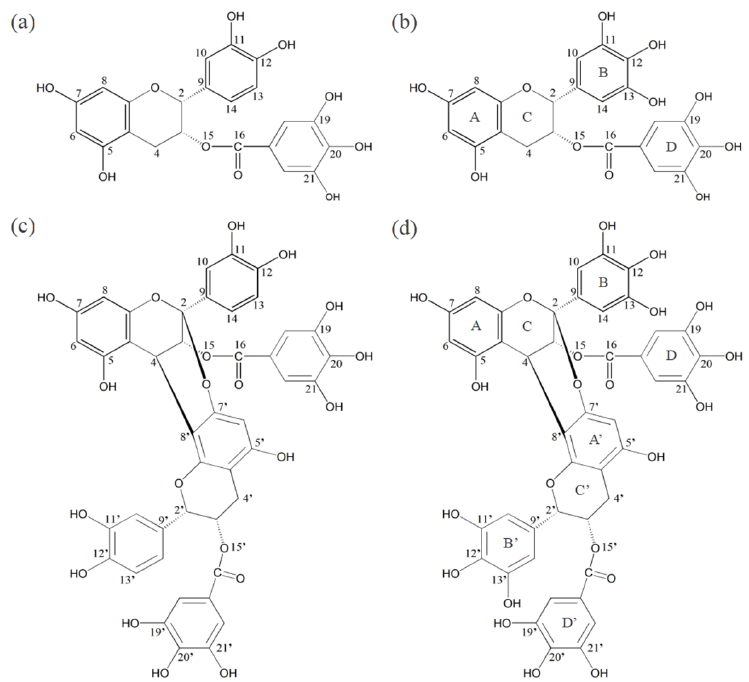
Figure 1. The molecular structure diagrams of the four characteristic structural units from PT: ( a ) ECG, ( b ) EGCG, ( c ) A − ECG dimer, ( d ) A − EGCG